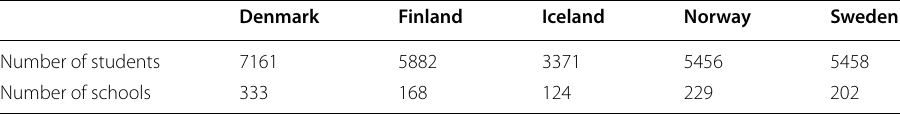
Table 1 Description of sample for each of the five Nordic